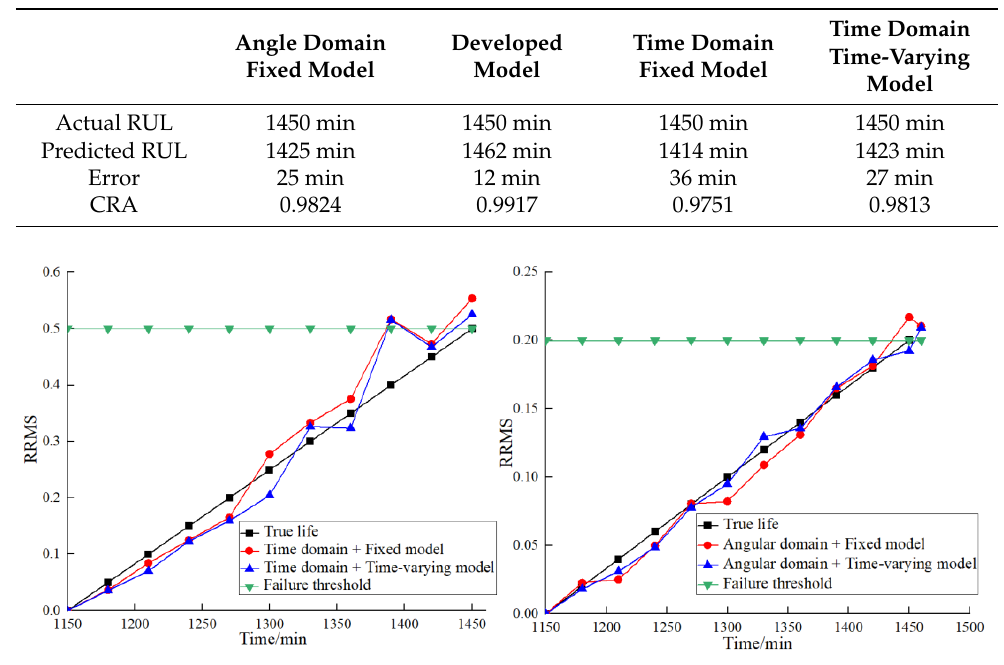
Table 5. Comparison of RUL prediction results of four methods.